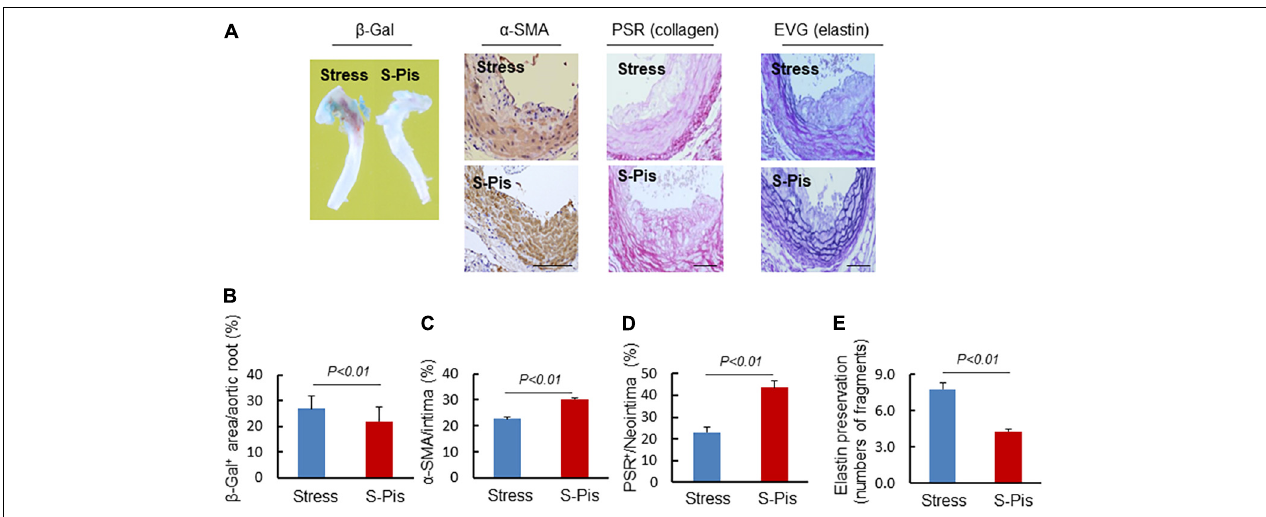
FIGURE 5 | Histological characterization of atherosclerotic plaques in aortic roots of the Stress and S-Pis groups. (A) Representative images were used to assess vascular senescence, α -SMCs, collagen and elastin disruption, and. (B–E) The areas for β -Gal + , α -SMCs, PSR + staining and the elastic disruption degree in atherosclerotic lesions were quantified for each section. Results are expressed as the ratio of β -Gal + area to the total aortic root, the ratio of the positively stained area ( α -SMCs, PSR + ) to the neointimal area in the atherosclerotic lesions, and the elastic broken numbers in the atherosclerotic lesions. Values are presented as means ± SEM ( n = 6–7). p < 0.01 vs. Stress group by Student’s t -test. Scale bars: 50 µ m.